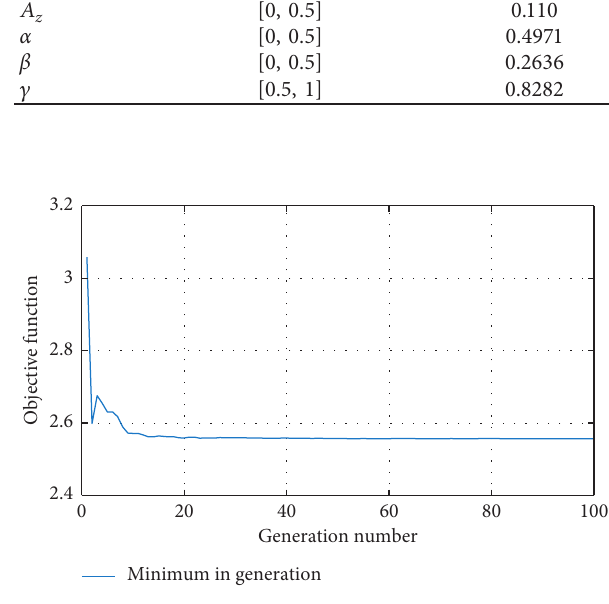
Figure 2: Convergence of the genetic algorithm.